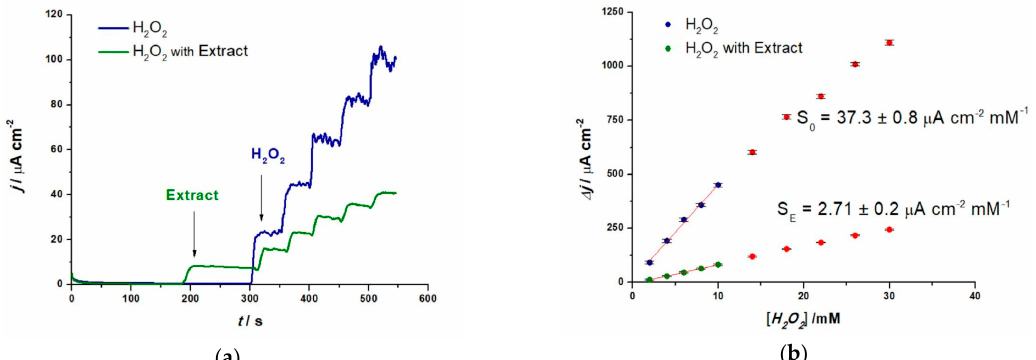
Figure 6. ( a ) Fixed potential amperometry at 0.55 V vs. Ag/AgCl for H 2 O 2 sensor in the presence and absence of 2.Hf Ab US extract in 0.1 M NaPB, pH = 7.0; ( b ) Corresponding calibration plots.